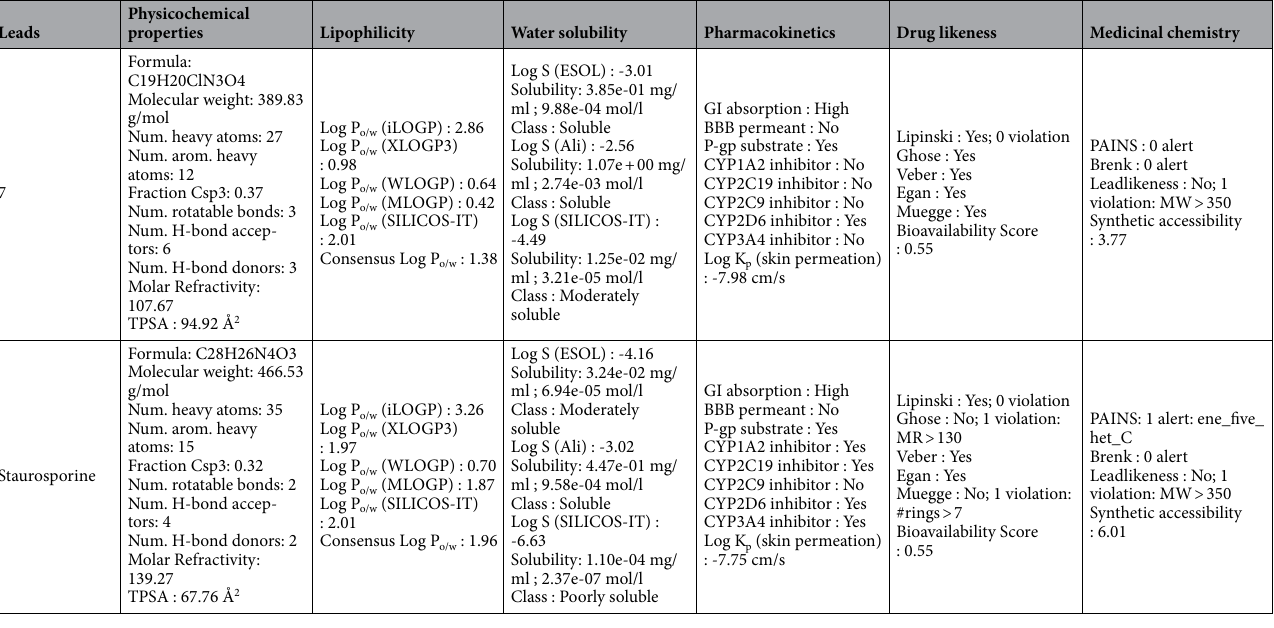
Table 4. Physico-chemical properties, lipophilicity, solubility, pharmacokinetic, drug likeness and medicinal chemistry properties of the PI3K-α and PKC-η